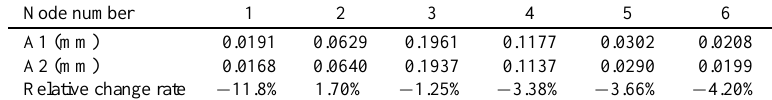
Table 1 Effect of thrust bearing on lateral shaft vibration